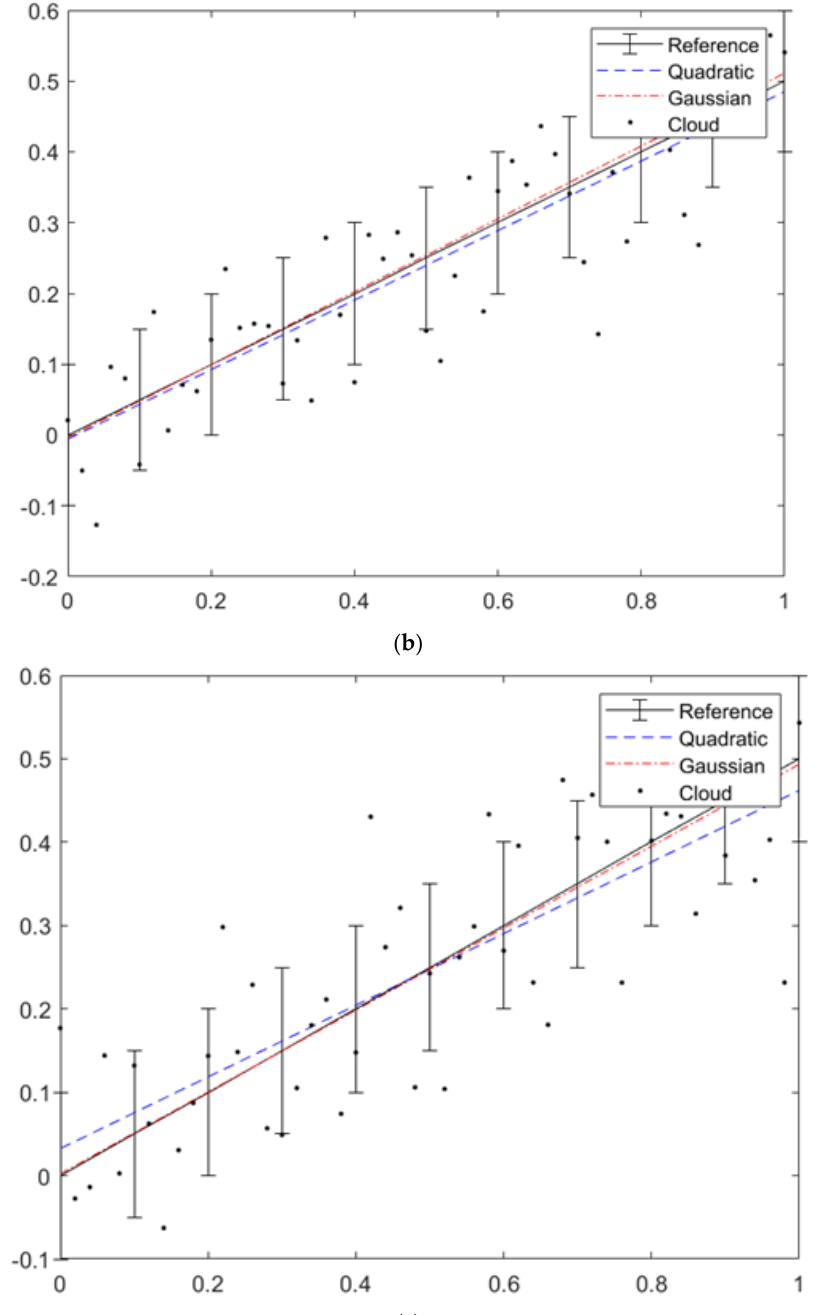
Figure 3. Comparing the least-squares (quadratic) and the stochastic (Gaussian) regressions for three different situations ( a – c ), and three different couples ( a , b